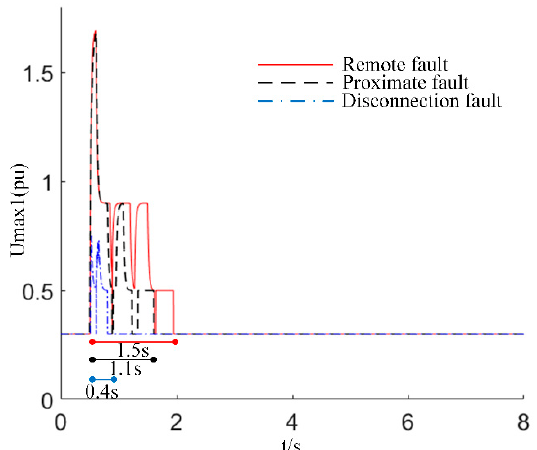
Figure 12. The fuzzy amplitude limiter for Umax1 .